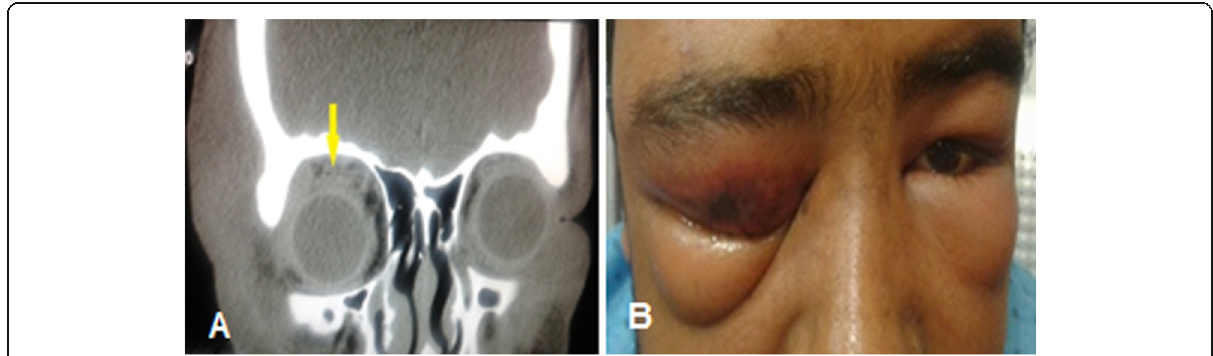
Fig. 4 Superior orbital cellulitis due to unknown insect bite that was managed with intravenous antibiotics without any surgical intervention, a external eye examination shows eyelids edema and upper lid redness with a small skin necrosis in site of the bite, b Orbital CT scan coronal view revealed superior orbital infiltration without abscess